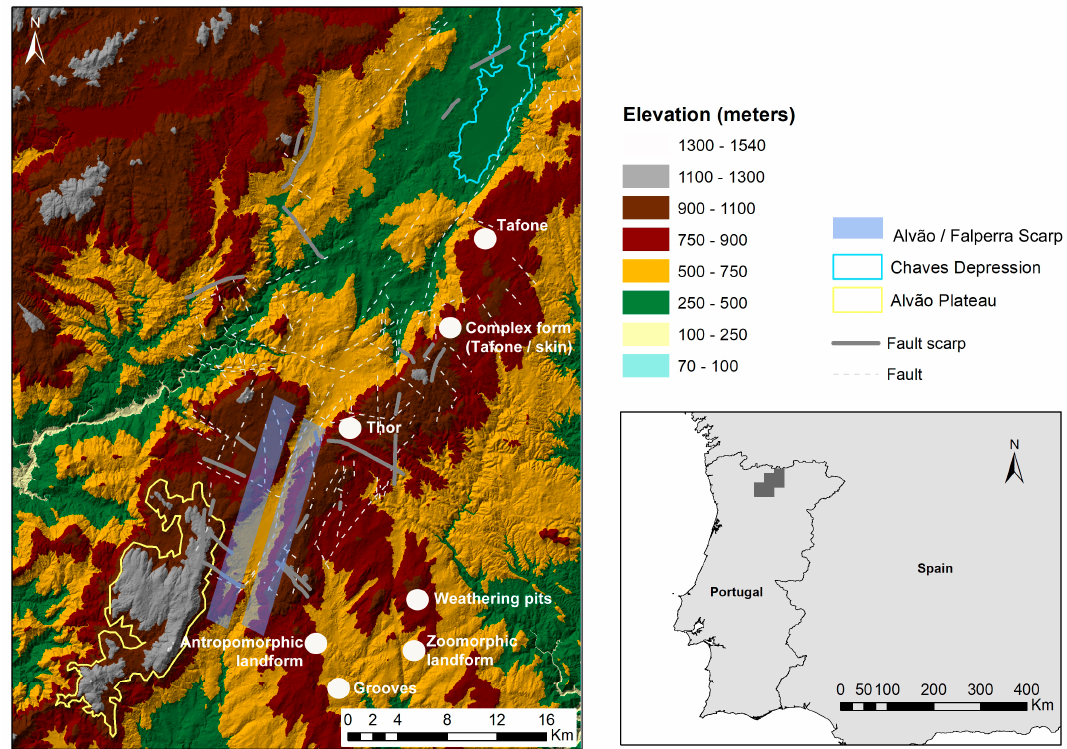
Figure 1. Morphostructural map of the study area (adapted from: Martins, 2017 [24]).